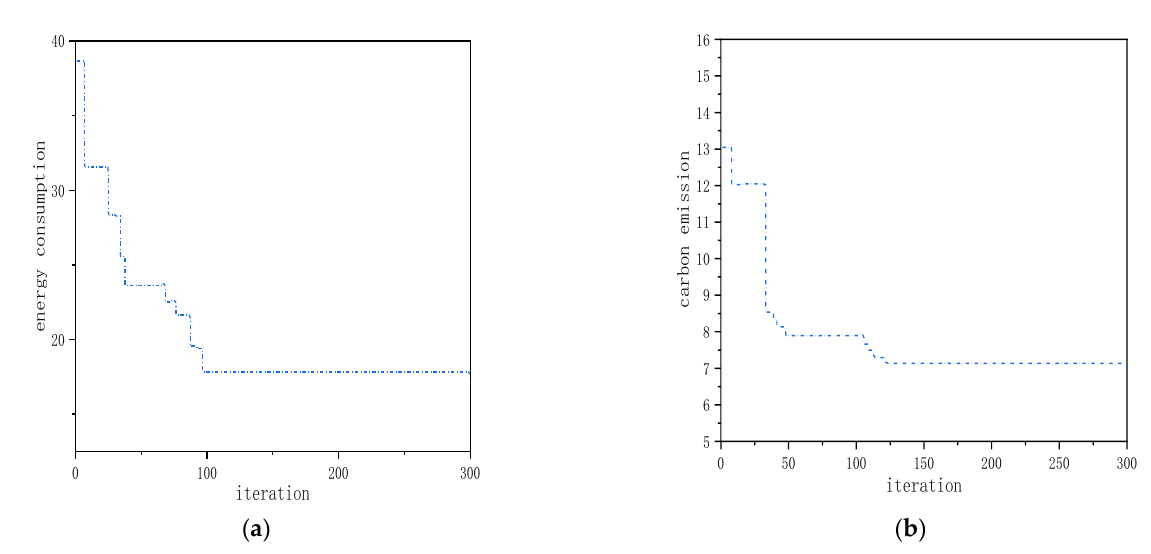
Figure 8. Iterative convergence graph of blank 2. ( a ) Energy consumption ( b ) Carbon emission.